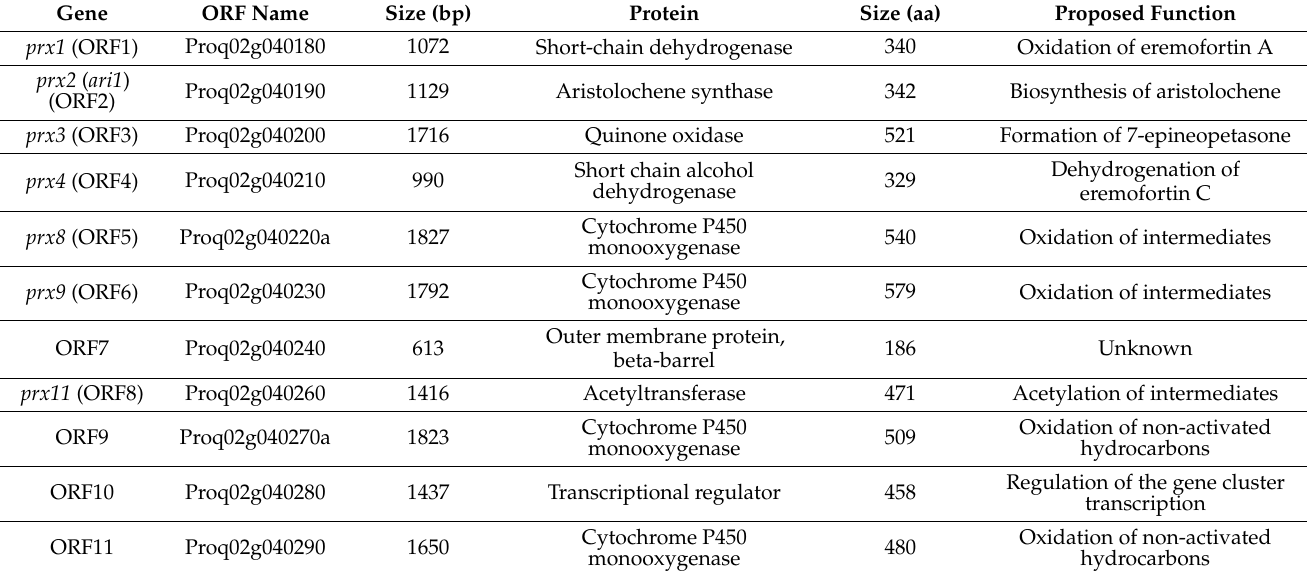
Table 3. PR-toxin biosynthetic gene cluster in P. roqueforti as proposed by